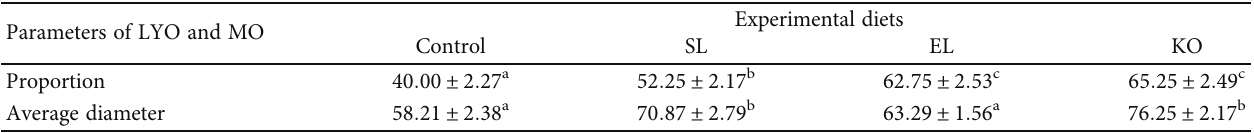
Experimental diets Control